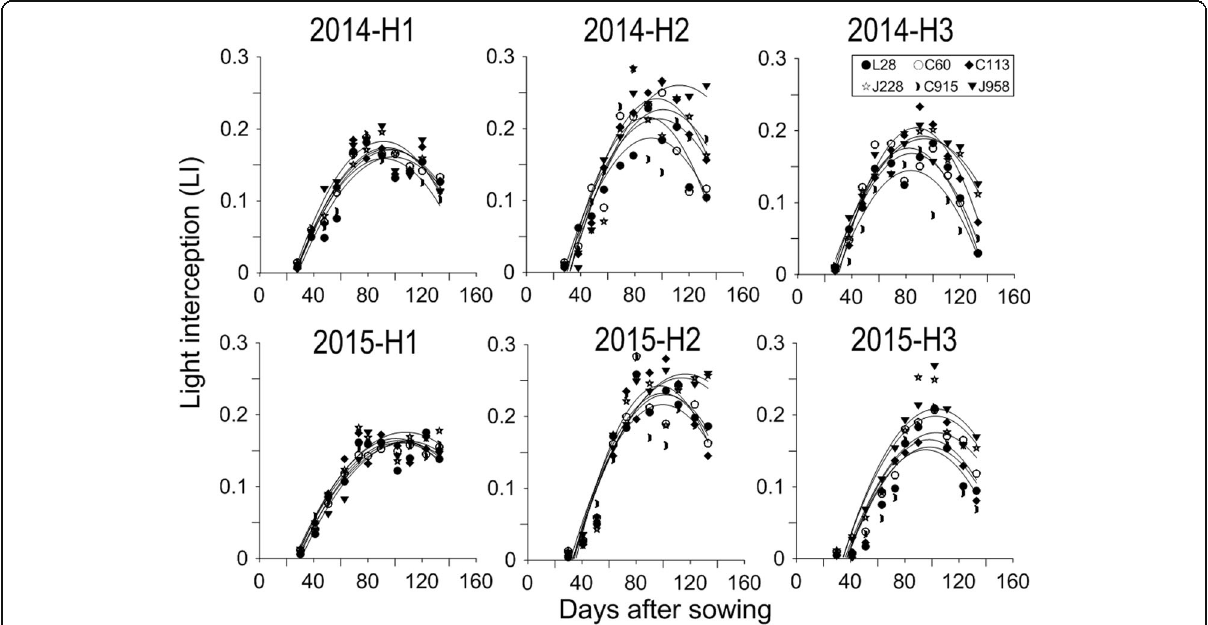
Fig. 3 LI vertical distribution of six different cotton varieties with different plant types during the cotton growth period in 2014 and